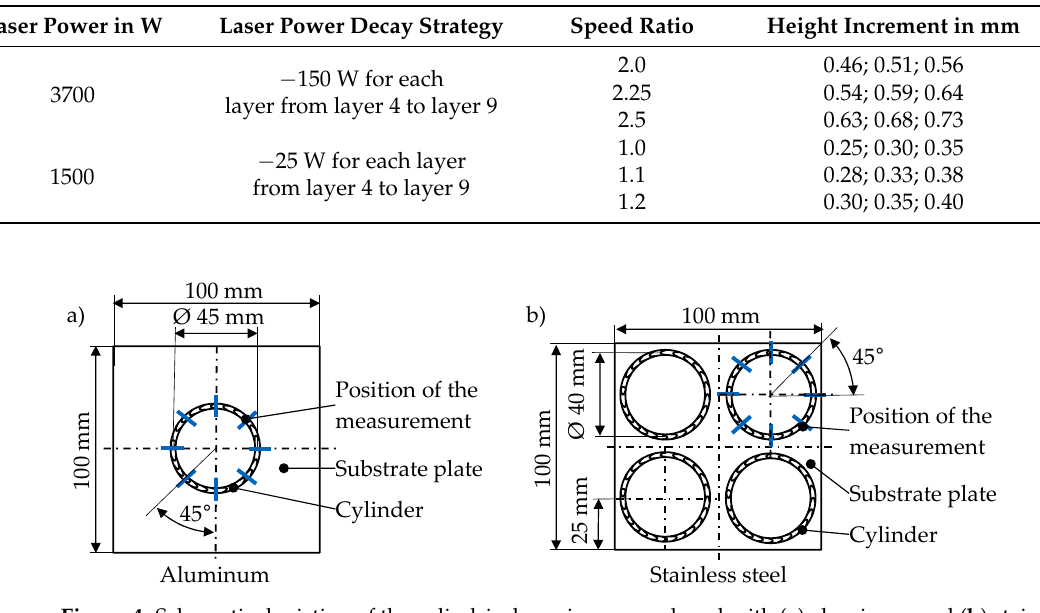
Figure 3. Schematic visualization of the specimens for the experiments with ( a ) aluminum and ( b ) stainless steel.